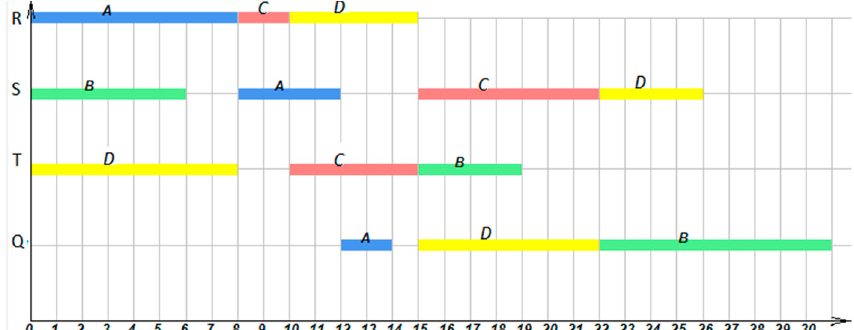
Figure 1. An example of a JSS problem solution (Gantt chart)